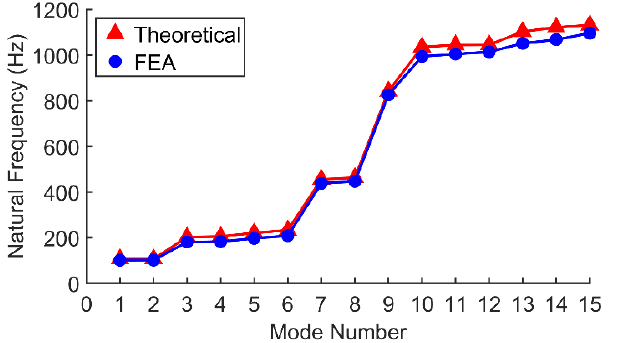
Figure 6. The theoretical natural frequency and FEA simulation natural frequency.